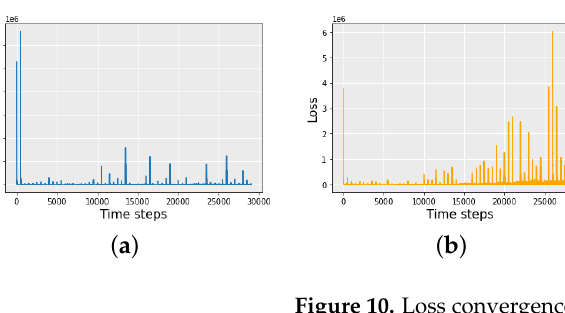
Figure 10. Loss convergence of the DQN algorithm in a heterogeneous leader-follower MAS, includ- ing N = 5 agents in P = 3 different clusters, during 30,000 time steps by considering time-delay and distance-based reward under FGSM, FGM, and BIM adversarial attacks. ( a ) DQN average loss in a leader-follower MAS without adversarial attack. ( b ) DQN average loss in a leader-follower MAS under FGSM adversarial attack. ( c ) DQN average loss in a leader-follower MAS under FGM adversarial attack. ( d ) DQN average loss in a leader-follower MAS under BIM adversarial